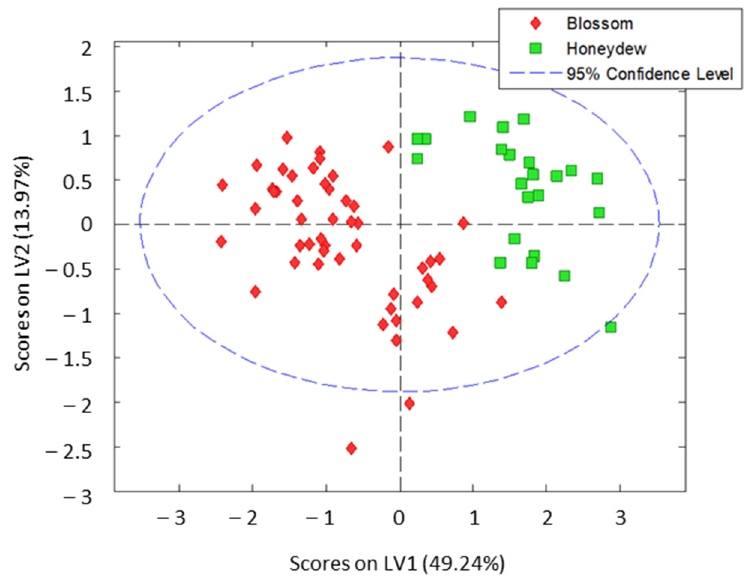
Figure 4. PLS-DA results for the classification of honeys according to both blossom or honeydew origin. Three latent variables were used to build the model.